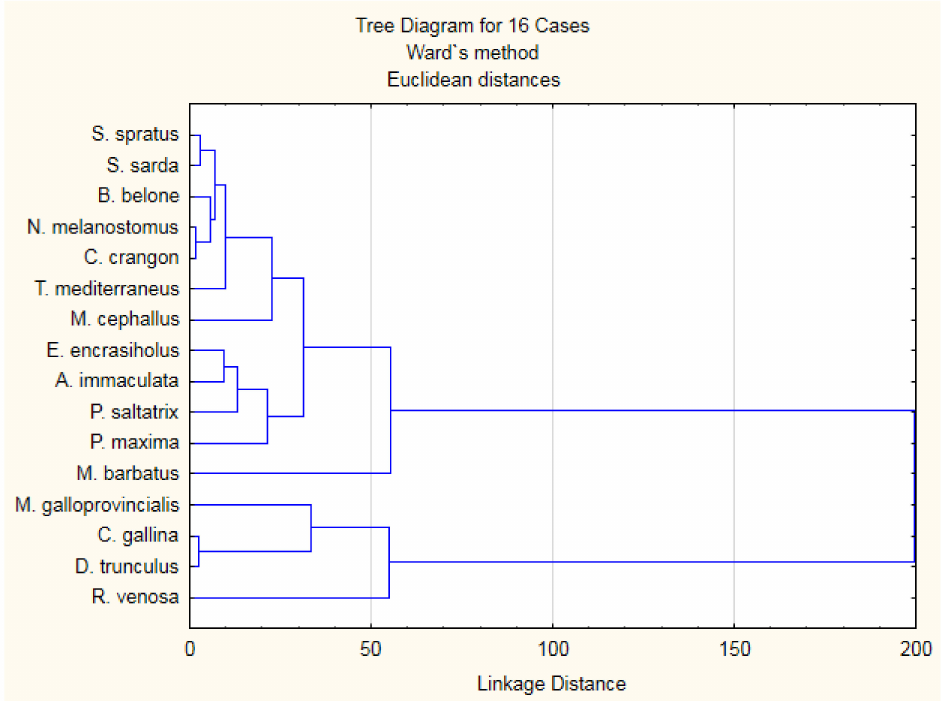
Figure 4. Hierarchical clustering analysis of the eleven fish and 5 shellfish species from the Black